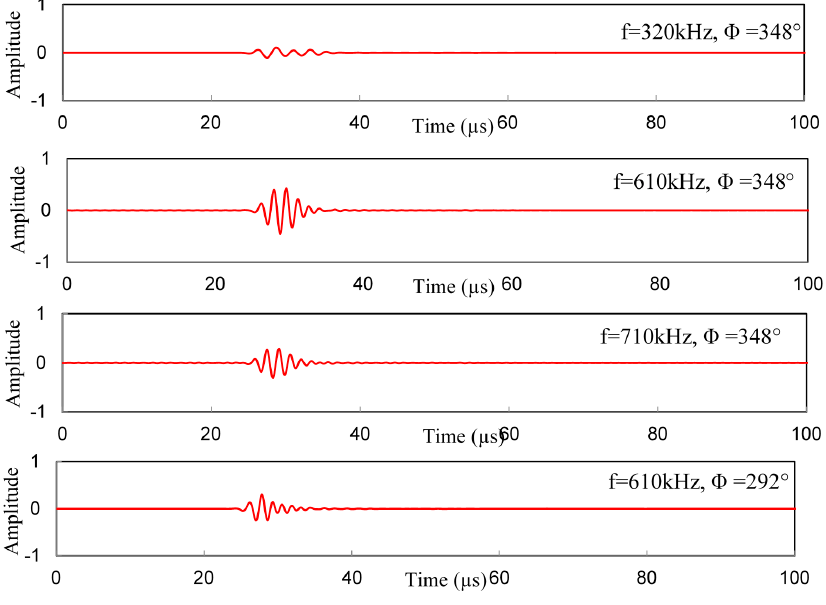
Figure 12. Sensing signals for different sets of frequency–location ( θ “ 27 ˝